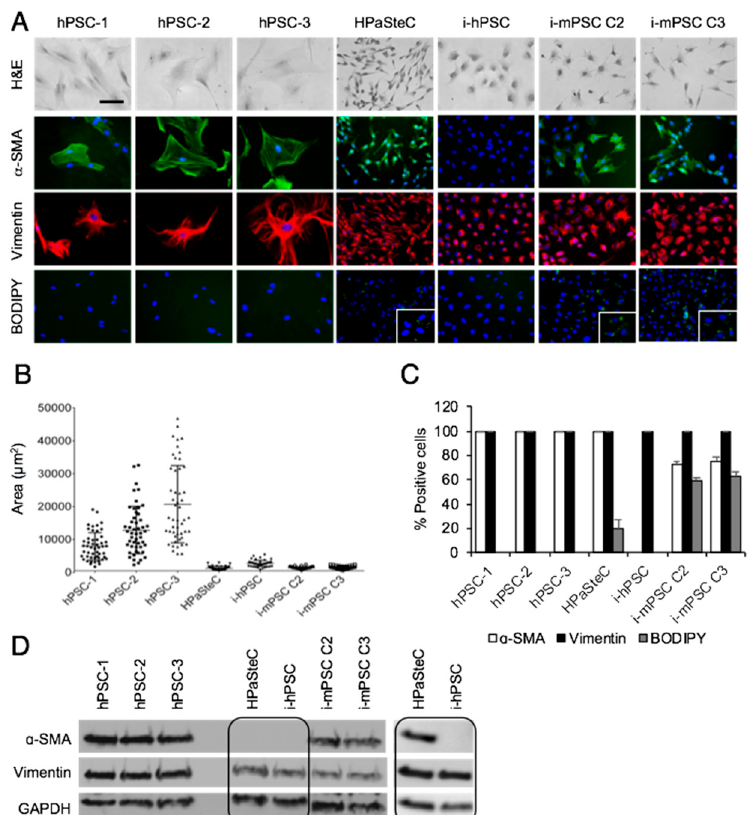
Figure 1. Phenotypic characterization of pancreatic stellate cells. ( A ) For morphological analysis, cells were stained with hematoxylin and eosin (H&E), BODIPY for detection of cytoplasmic lipid droplets and immunostained with anti- α -SMA (green) and anti-vimentin (red) antibodies. Nuclei were stained with DAPI (blue). Scale bar = 100 μ M. ( B ) Cell size of the various PSC cultures was determined by measurement of the area of 50 cells for each PSC culture using FIJI software. ( C ) Number of positive cells for α -SMA, vimentin, and BODIPY in percentage. ( D ) Cells were lysed and proteins subjected to immunoblotting using anti- α -SMA and anti-vimentin antibodies. Due to high exposure time required for detection, α -SMA expression in HPaSteC cells is also presented in a separate blot. GAPDH was used as a loading control. PSC, pancreatic stellate cell; hPSC, human primary PDAC-derived PSC culture; HPaSteC, PSCs from normal human pancreas; i-hPSC, immortalized human PSCs; i-mPSC C2 and C3, immortalized mouse PSCs clone 2 and